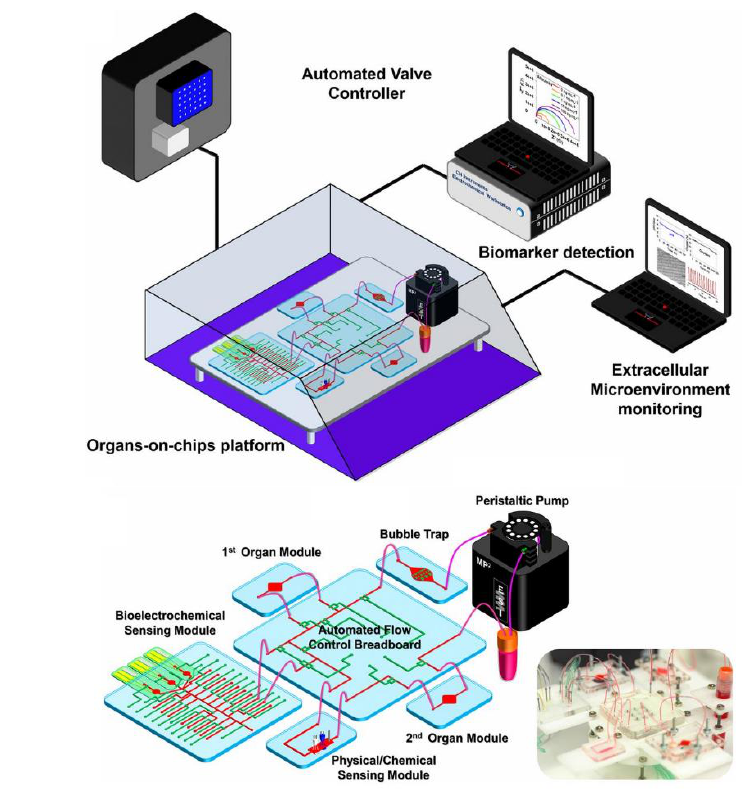
Figure 5. The idea of an automated monitoring and analysis platform integrating multiple OoCs with sensors for maintaining appropriate temperature and CO 2 levels [66]. ( A ) The schematic of a multi-OoC platform in a benchtop incubator, which is connected with automated pneumatic valve controller, electronics for operating physical sensors, potentiostat for measuring electrochemical signals, and a computer for central programmed integration of all commands. ( B ) The in-house designed multi-OoC platform contains a breadboard, microbioreactors, medium reservoir, a physical sensing suite, one or multiple electrochemical sensors, and bubble traps. Reproduced with permission from Proceedings of the National Academy of Sciences Copyright (2023). Table 1. Summary of different applications of deep learning used for OoCs.